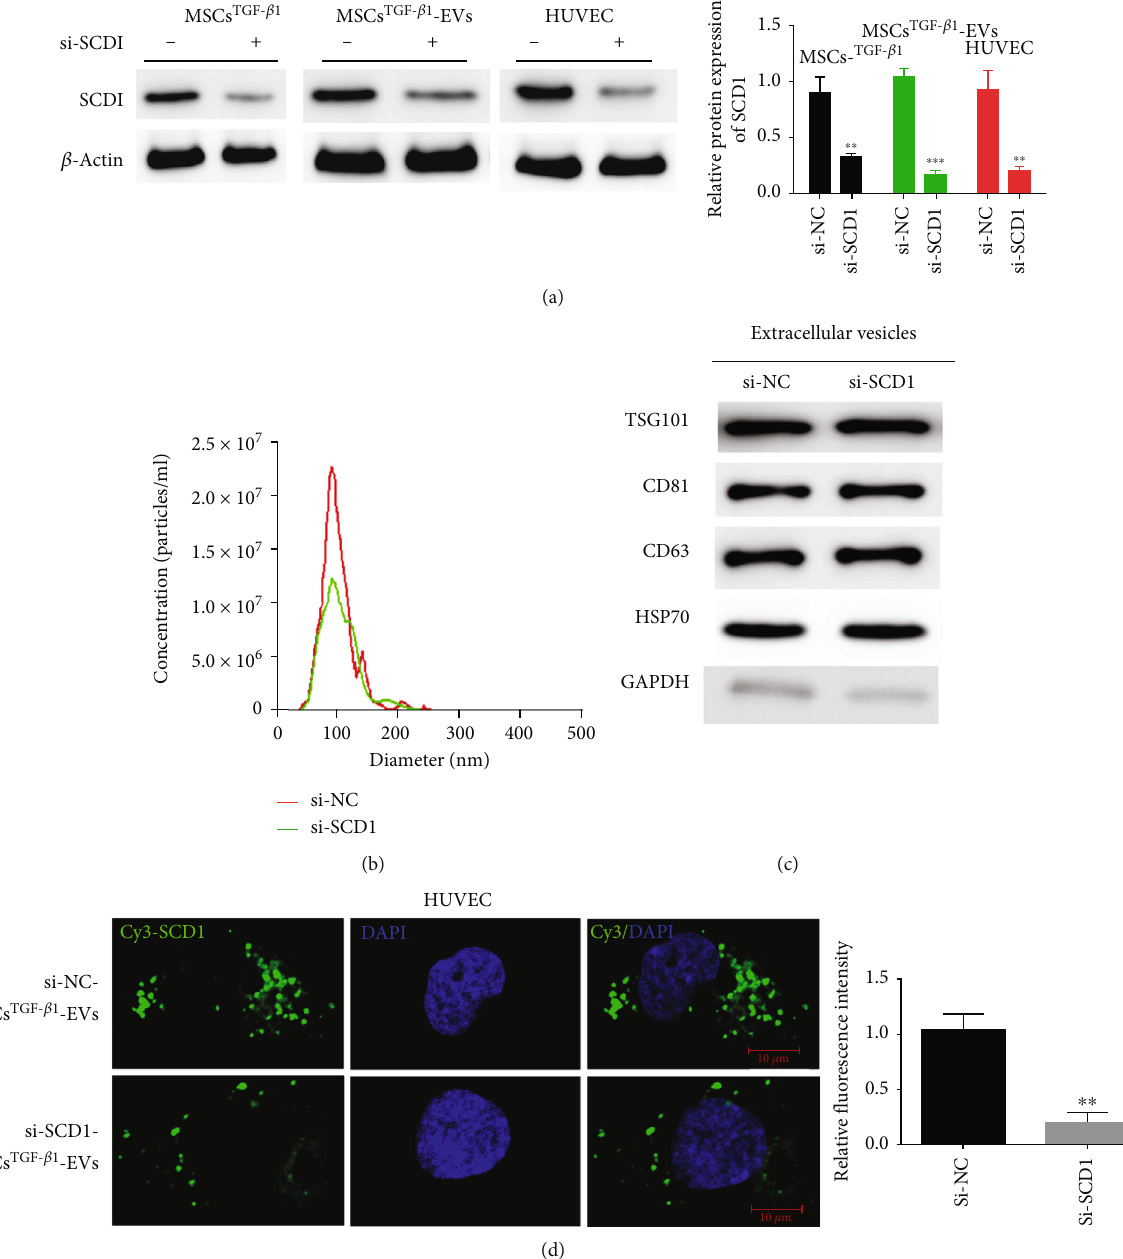
Figure 5: SCD1 is transferred to HUVECs by EVs. (a) The SCD1 level in MSCs TGF- β 1 , MSC TGF- β 1 -EVs transfected with si-NC and si-SCD1, target HUVECs after administrating si-NC-TGF- β 1-EVs or si-SCD1-TGF- β 1-EVs, and the e ffi ciency con fi rmed using western blotting and RT-PCR, n = 3 . (b) NTA of EVs derived from MSC TGF- β 1 -EVs transfected with si-NC and si-SCD1, n = 3 . (c) Western blot analysis of EV proteins including TSG101, CD81, CD63, and HSP70, n = 3 . (d) Representative images of Cy3-labeled EV-SCD1 internalized by HUVECs after administration of MSC TGF- β 1 -EV-si-NC or MSC TGF- β 1 -EV-si-SCD1 (left). Quantitative analysis of relative fl uorescence intensity (right), n = 3 . Data are expressed as mean ± SD ; ∗∗ P < 0 : 01 . MSCs: mesenchymal stem cells; EVs: extracellular vesicles; HUVECs: human umbilical vein endothelial